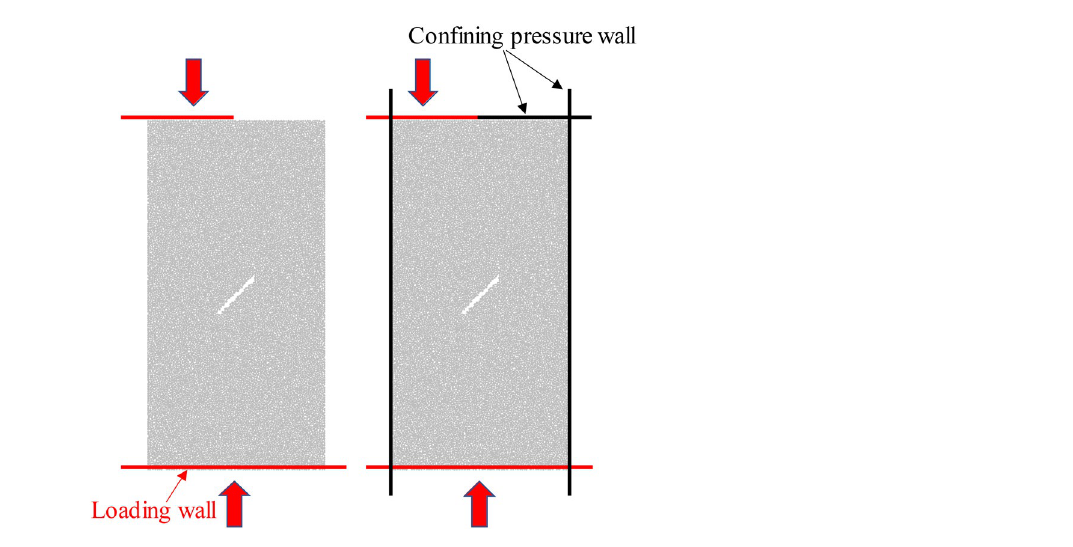
Figure 3. Schematic diagram of eccentric load